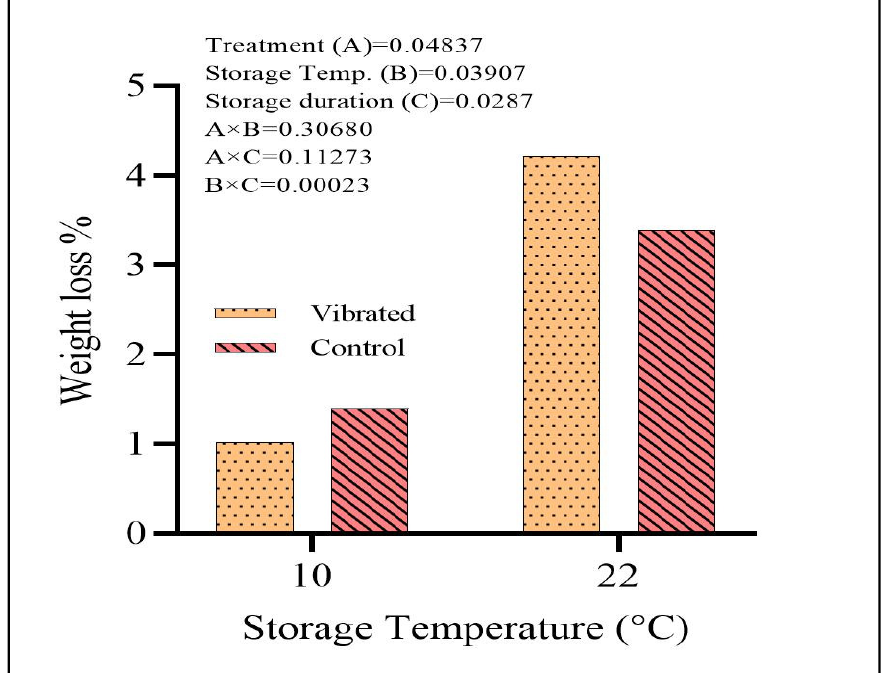
Figure 2. Weight loss (%) of vibrated and non-vibrated (Control) tomato fruits stored at 10 and 22